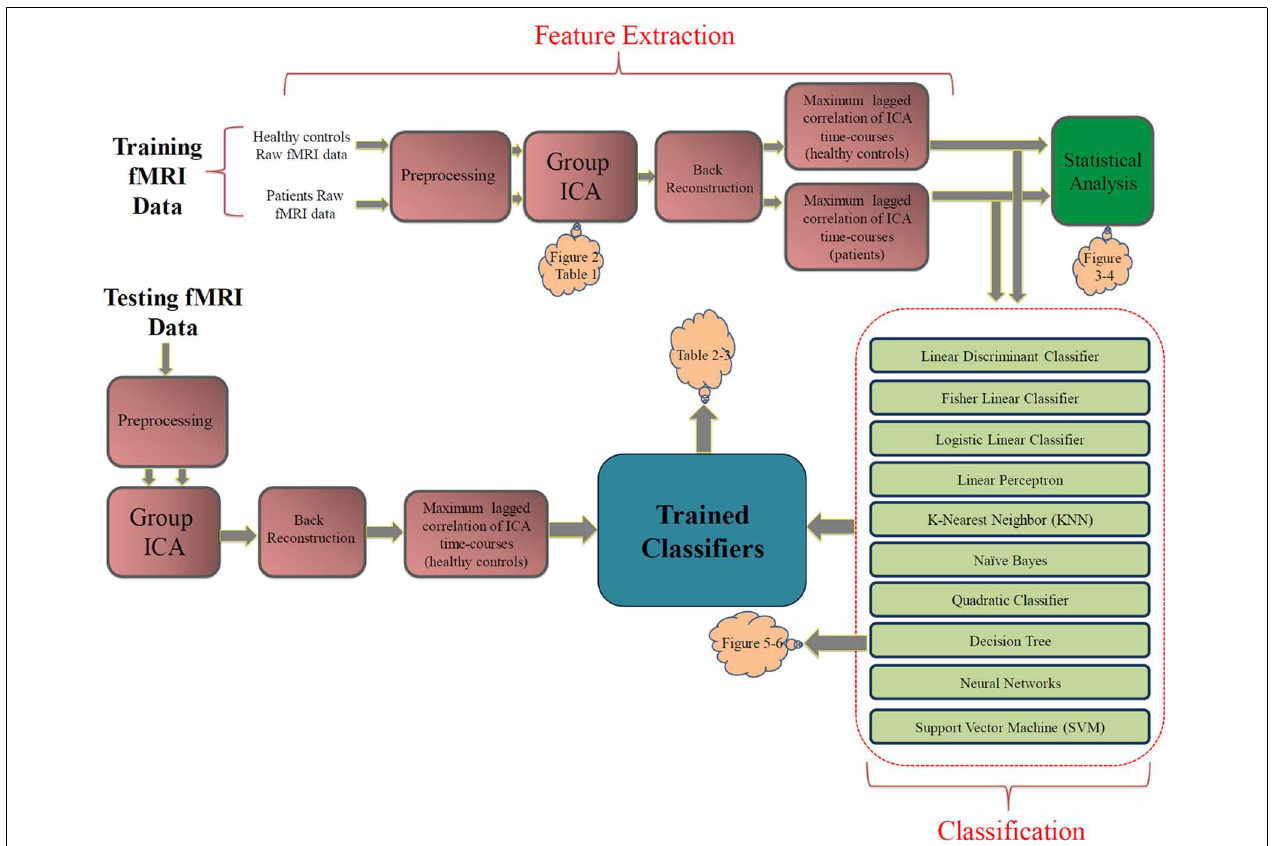
FIGURE 1 | The proposed approach. Thepinkblocks on thetop showthe feature extraction steps. Thestatistical analysis box(green)is not part of the